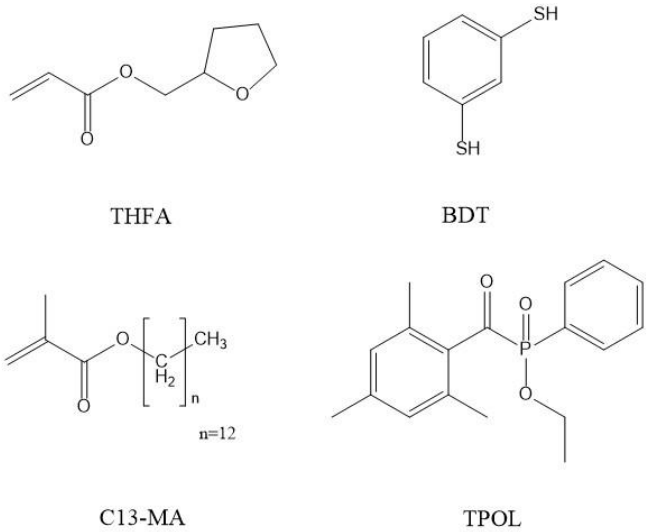
Figure 1. Chemical structures of tetrahydrofurfuryl acrylate (THFA), 1,3-benzenedithiol (BDT), tridecyl methacrylate (C13-MA), and ethyl(2,4,6-trimethylbenzoyl) phenylphosphinate (TPOL).